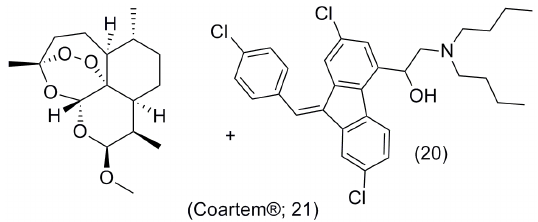
Figure 6 - Structure of drugs used in Coartem ® combination 21